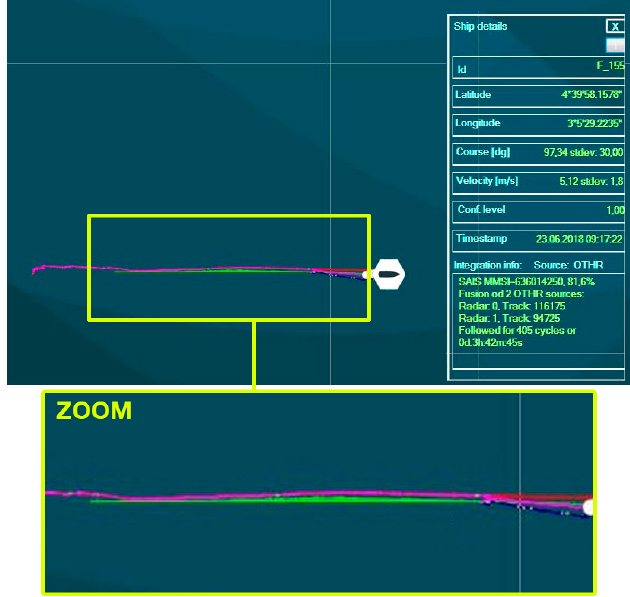
Figure 4. Case” (dark blue trace: radar 0 data, green trace: radar 1 data, purple trace: fused track, red trace: AIS data).